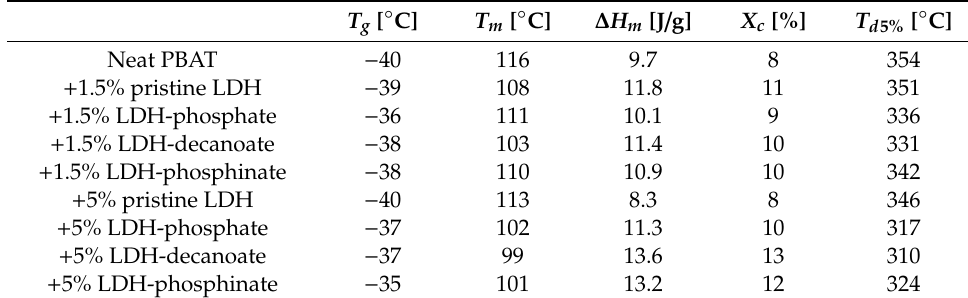
Table 3. DSC and TGA results of neat PBAT and PBAT nanocomposites with 1.5 and 5 wt % of pristine LDH, LDH-phosphate, LDH-decanoate, and LDH-phosphinate.